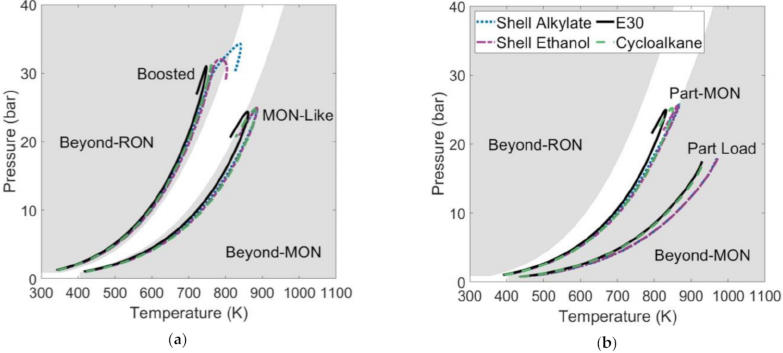
Figure 3. Pressure-Temperature trajectories for ( a ) Boosted, MON-Like, ( b ) Part-MON, and Light- Load SI points for Shell Alkylate, Shell Ethanol, E30, and High Cycloalkane fuels at 35 ◦ CA aTDC f .